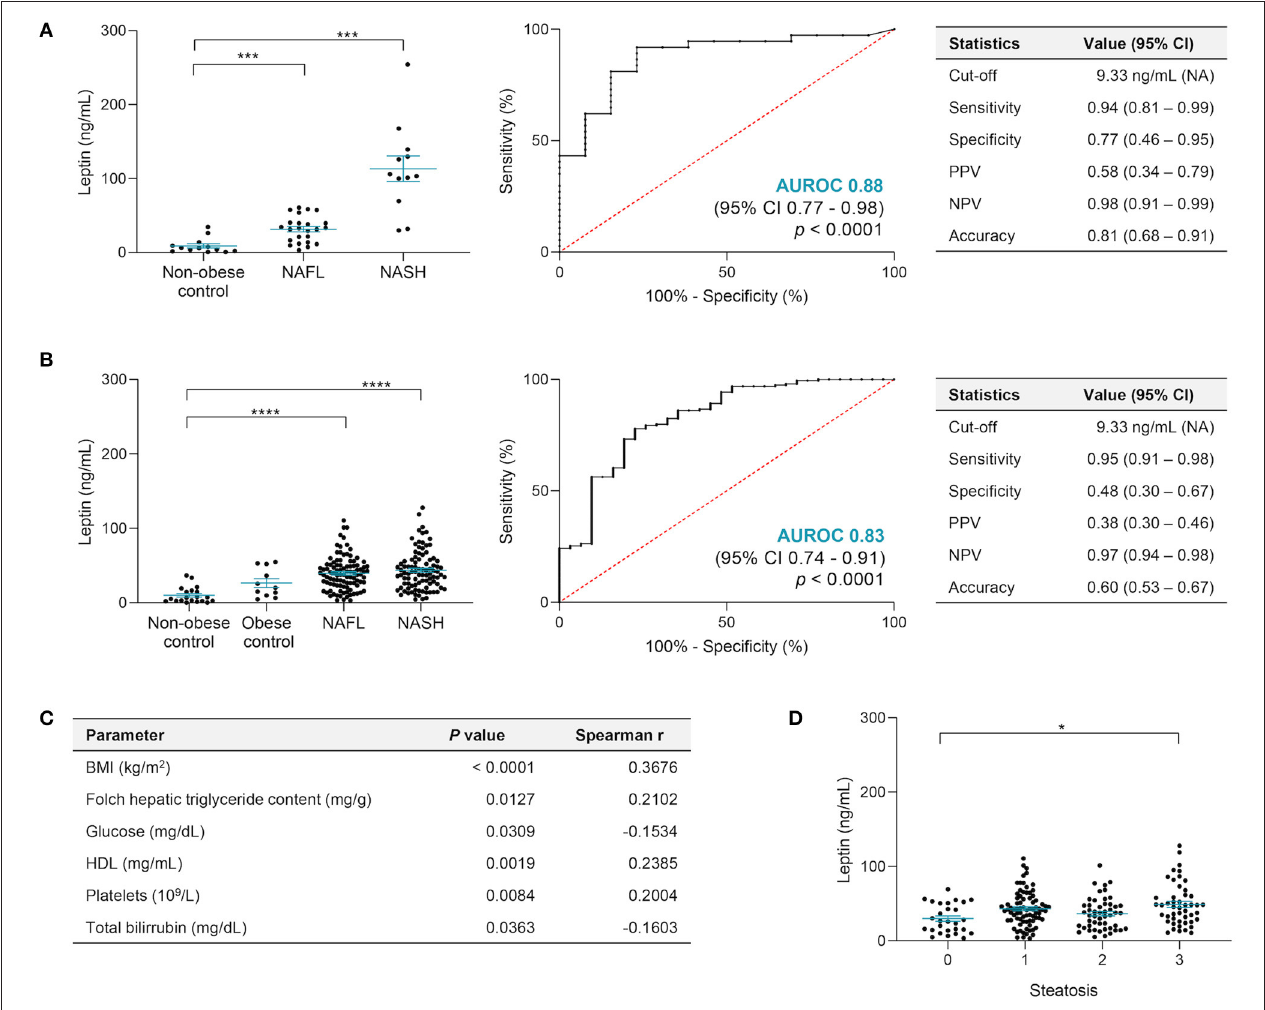
FIGURE 1 | Leptin serum levels allow to distinguish NAFLD. (A) In the discovery cohort, leptin levels were significantly higher in NAFL and NASH patients compared with non-obese, healthy-liver controls, presenting an AUROC value of 0.88 when distinguishing controls ( n = 13) from NAFLD patients ( n = 36), with very high general accuracy and NPV. (B) In the validation cohort, the leptin levels did not show differences among healthy controls, non-obese or obese, and confirmed increased levels in NAFL and NASH. Leptin presented good performance assay results when distinguishing healthy controls ( n = 31) from NAFLD ( n = 194), with an AUROC value of 0.83 and overall accuracy of 0.60 when applied the cutoff value of > 9.33ng/ml leptin for NAFLD diagnosis established in the discovery cohort. (C) Main correlations found between leptin and other parameters in the validation cohort: BMI values ( n = 199), hepatic TG evaluated by Folch method ( n = 140; mg TG/g liver tissue), glucose ( n = 198), HDL ( n = 167), platelets ( n = 172), and total bilirubin ( n = 171). (D) Leptin levels increased with steatosis severity in the validation cohort. The x -axis represents the histological grade of steatosis, ranging from 0 to 3. There was a significant difference between grade 0 vs. 3 ( n = 28, grade 0; n = 80, grade 1; n = 49, grade 2; n = 48, grade 3). Leptin levels depicted as mean ± SEM. BMI, body mass index; CI, confidence interval; HDL, high-density lipoprotein; NAFL, non-alcoholic fatty liver; NAFLD, nonalcoholic fatty liver disease; NASH, nonalcoholic steatohepatitis; NPV, negative predictive value; PPV, positive predictive